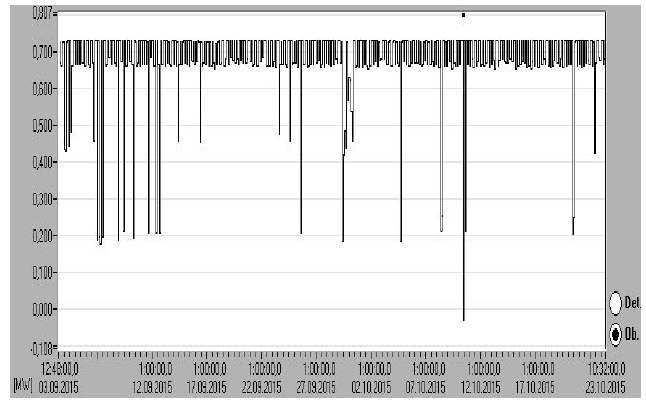
Fig. 6. Course of entire active power over the whole period observed at the location of BS